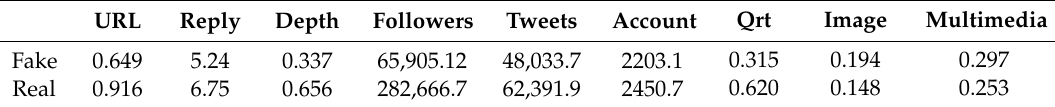
Figure 5. Data distribution boxplot of respective best features. Table 3. Average value of best